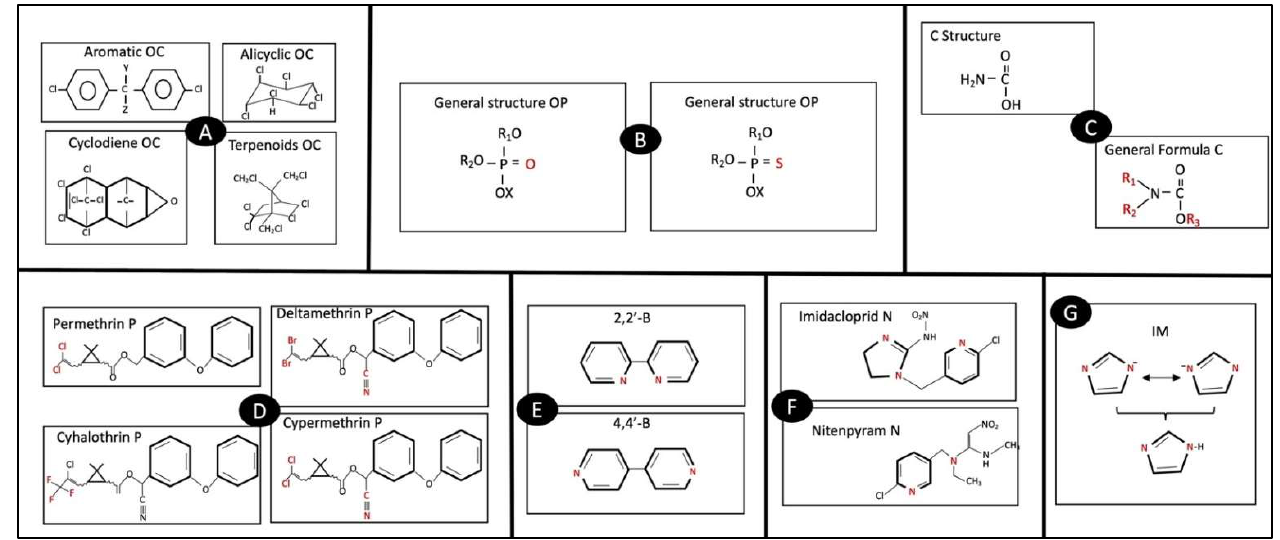
Figure 1. General structure of organochlorines ( A ), organophosphates ( B ), carbamates ( C ), Pyrethoids ( D ), Bipyridyls ( E ), Neonicotinoids ( F ), Imidazole ( G ).